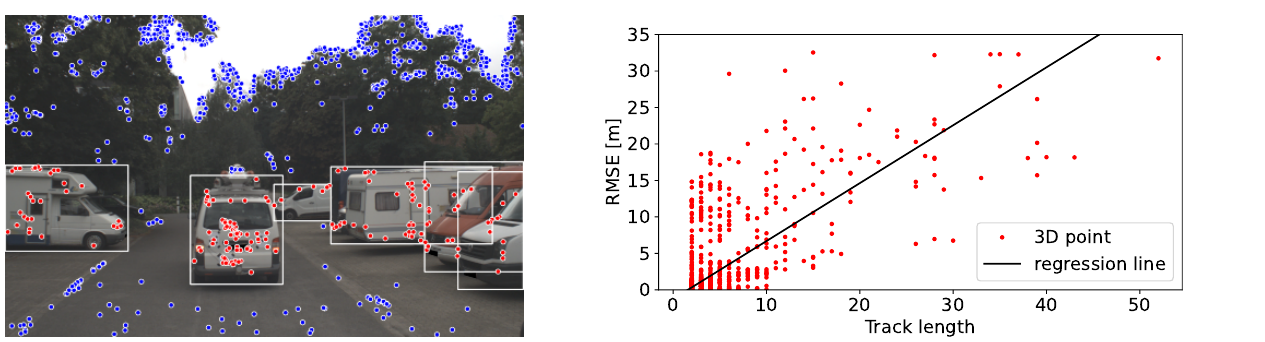
Figure 5. Result of the extracted potentially dynamic objects Figure 6. Relation between the track length given by the number superimposed with the detected feature points. Blue : Feature of observations of a 3D point, and the RMSE of the position of points in the static environment. Red : Feature points situated on potentially dynamic 3D potentially dynamic objects.